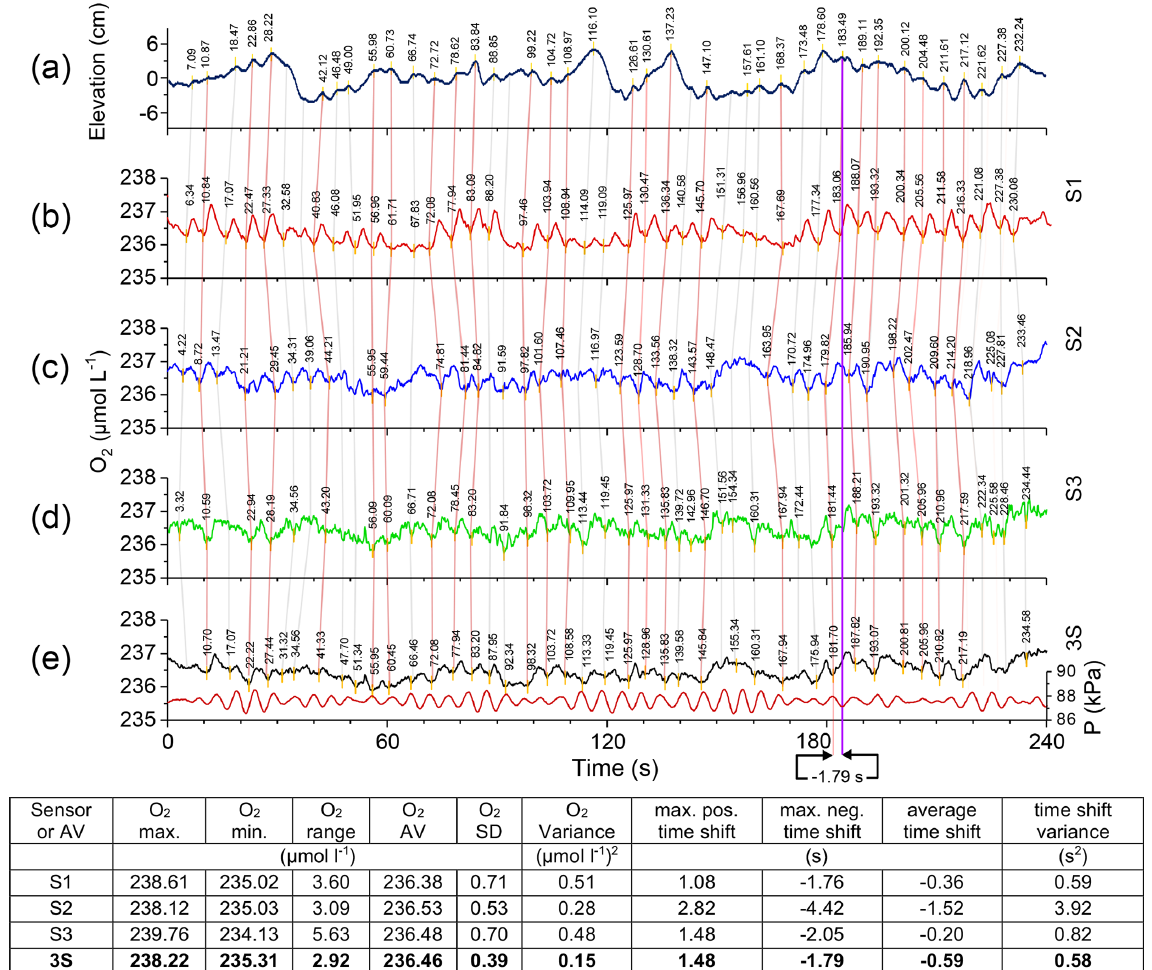
Figure 3. The 4min interval of nighttime data recorded on 13 July (04:53:20–04:57:20) comparing the simultaneous elevation, oxygen, and pressure readings recorded by the 3OEC. Elevation expresses the instantaneous relative elevation of a water parcel that is moved up and down in the water column (see text). (a) Elevation (blue line) and (b–d) the associated O 2 concentrations recorded by the three optodes (red, blue, and green lines) and their (e) average (black line). Brown line in (e) depicts pressure P (scale right y axis) at the height of the ADV. The data were smoothed by a 2.5s running average. In the absence of a time shift, a minimum in O 2 change occurs when water displacement is zero, and points with zero O 2 change therefore are connected in this graph to points with no elevation change. Since this is a nighttime recording, O 2 minima cross-correlate with elevation maxima. Vertical red lines connect elevation maxima and associated O 2 minima as identified by the OriginLab 2017 software peak-finding algorithm (analysis of 2nd derivative). Vertical grey lines do the same, but in these cases one of the minima or maxima could not be identified by the peak-finding algorithm (manual fit). The instance of the largest temporary time shift ( − 1.79s) between elevation maximum and the corresponding 3S O 2 minimum observed within this 4min interval is indicated by the vertical purple line. The data listed below the graph reveal how the averaging of the O 2 signals reduces the variance of the O 2 signal in the flow measuring volume relative to the individual O 2